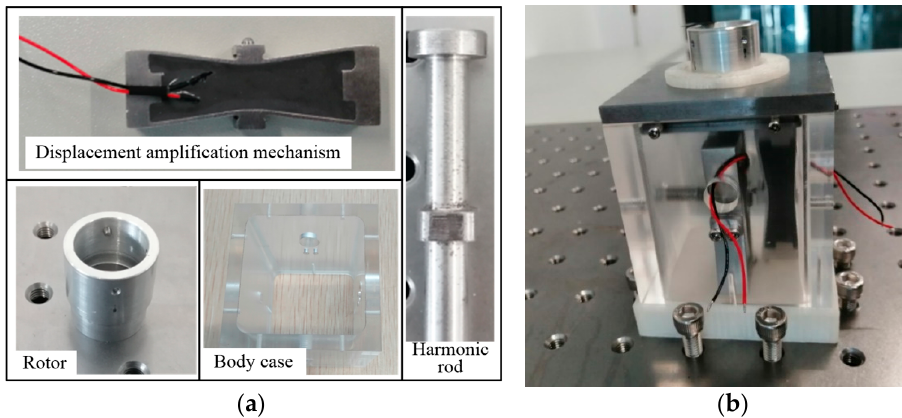
Figure 13. Experimental prototype of the piezoelectric actuator. ( a ) Prototype components; ( b ) Prototype assembly.